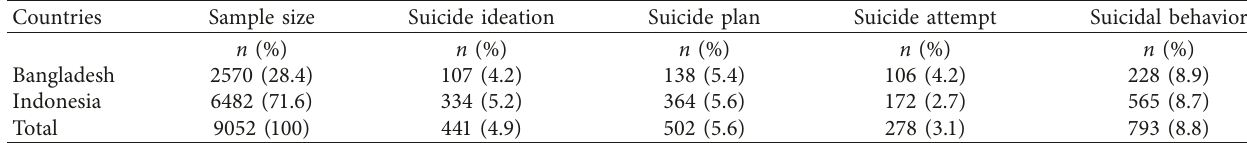
Table 1: The prevalence of suicidal behavior among adolescents in Bangladesh and